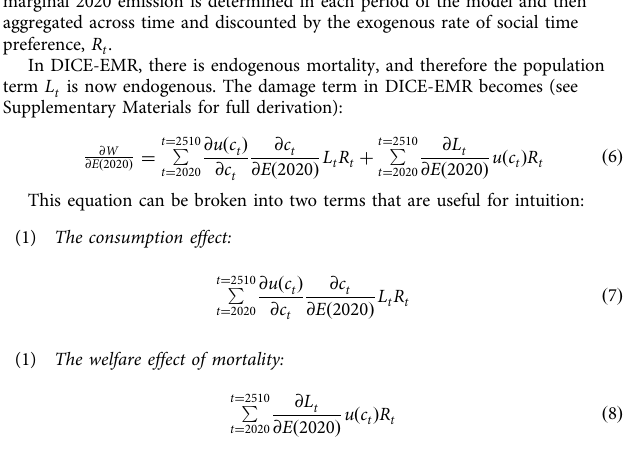
Fig. 6 Mortality damage function derived from systematic research synthesis estimates the mortality damage function: δ ð T t Þ ¼ β increase in global average atmospheric temperatures above preindustrial, β i 2 { β mortality rate (where for instance 0.05 represents a 5% increase in the mortality rate). See Supplementary Materials for detailed explanation of